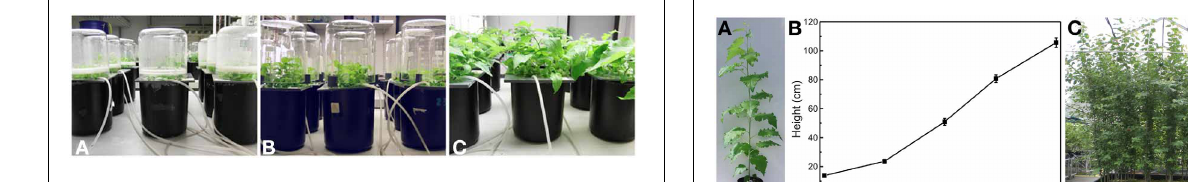
outdoors and initially avoiding full sun. After 54 days, the plants reached the height of about 1 m ( Figure 4 ), an aboveground biomass of 14 g and a belowground biomass of 4 g. If the plants are intended to be grown for longer time periods, pots with larger volumes, or use of large boxes are recommended ( Figure 4